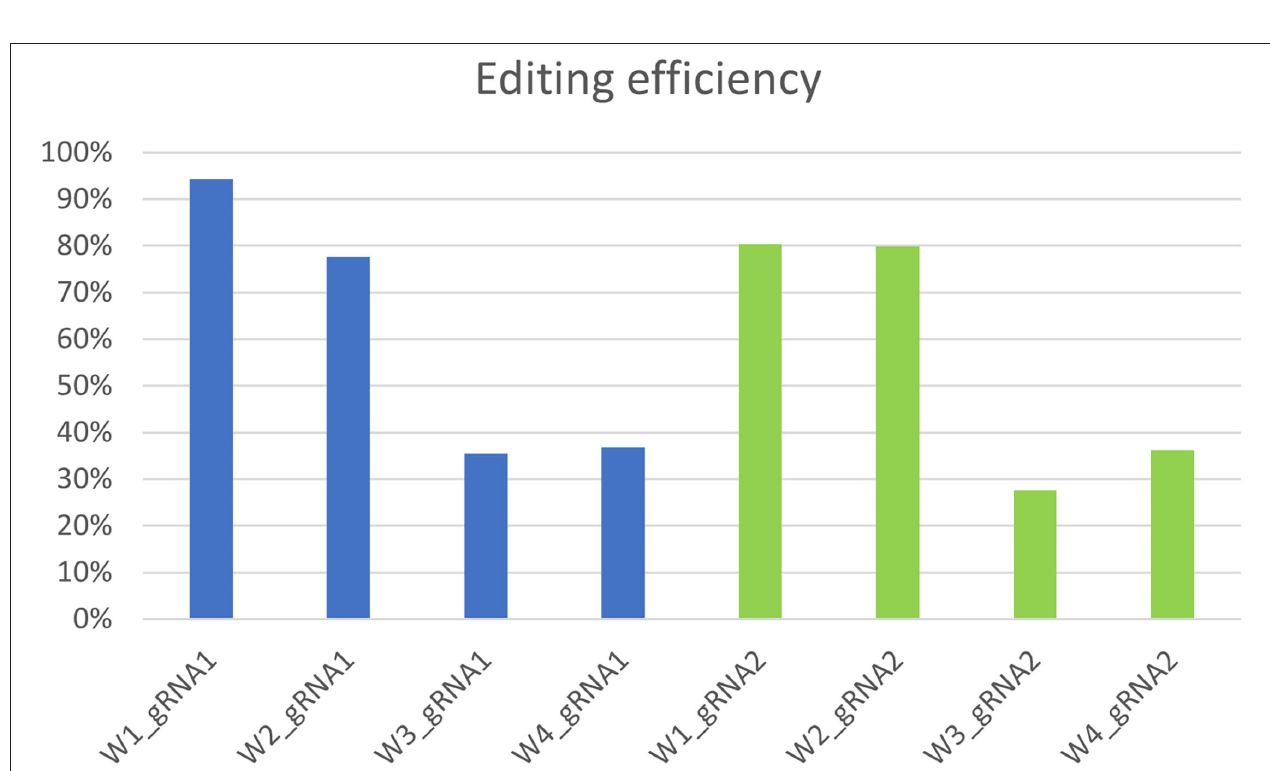
FIGURE 8 | Genotyping of targeted gene mutations induced by CRISPR/Cas9 on gRNA1 and gRNA2 in the transformed lines (W1–W4).